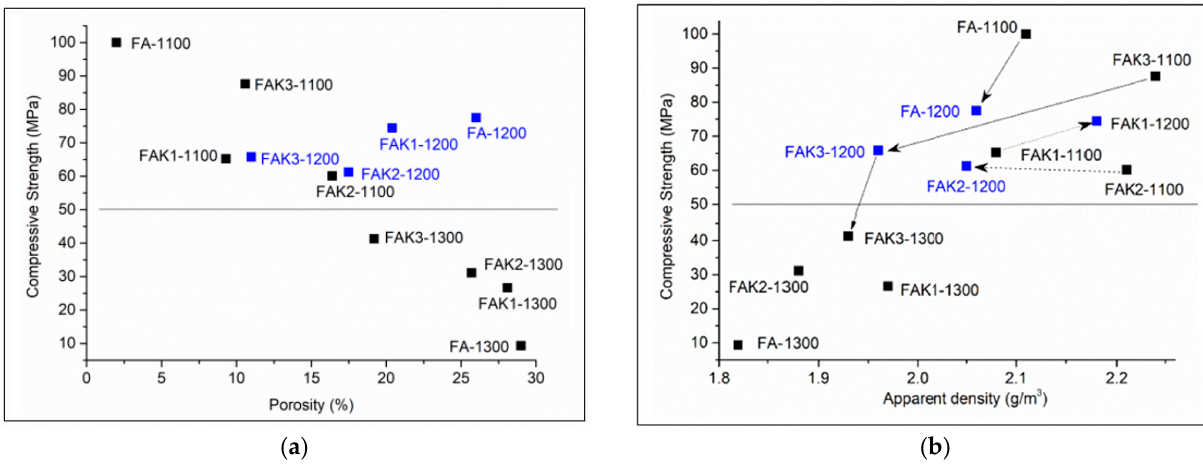
Figure 8. Compressive strength related to the porosity ( a ) and apparent density ( b